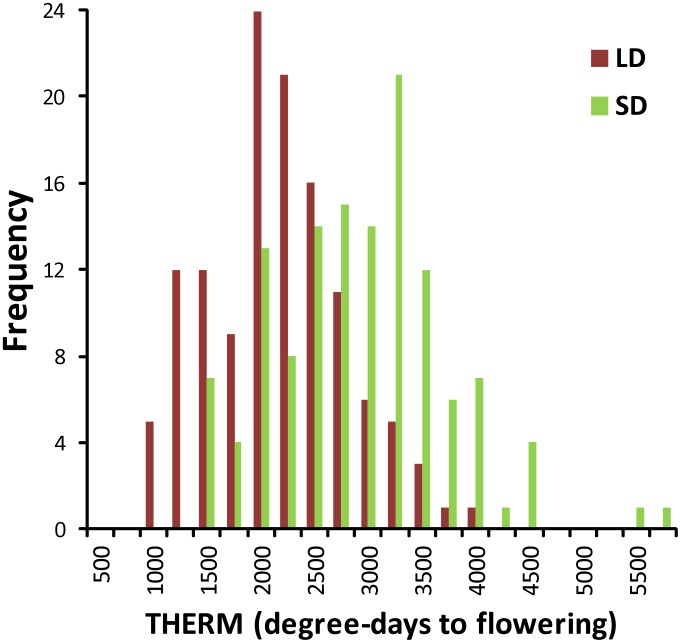
Frequency distribution for the thermal time to flowering (THERM) in the LMDH population.Plants were grown under long day (LD) and short day (SD) conditions in a glasshouse-based experiment. The mean THERM for Monty-028DH was 1839 degree-days (LD) and 2139 degree-days (SD). The mean THERM for Lynx-037DH was 2306 degree-days (LD) and 3094 degree-days (SD).